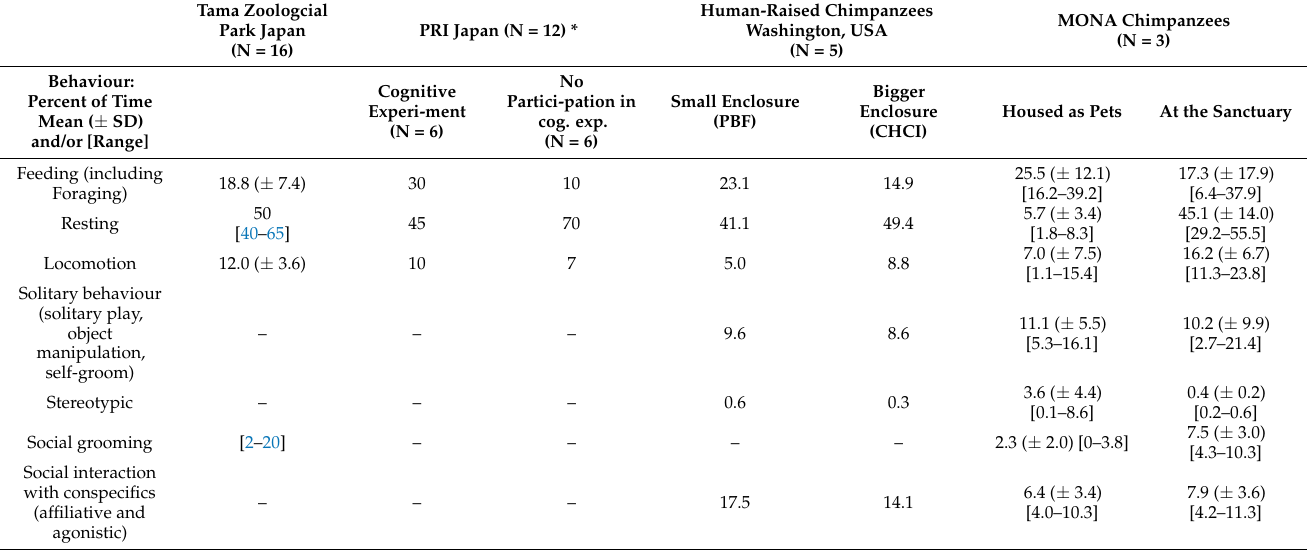
Table 2. Comparison of the activity budgets of our three chimpanzees to other captive chimpanzees (Tama Zoological Park [70] and Primate Research Institute (PRI) [71] in Japan; Central Washington University in Ellensburg [36]). Numbers refer to percentage of observation